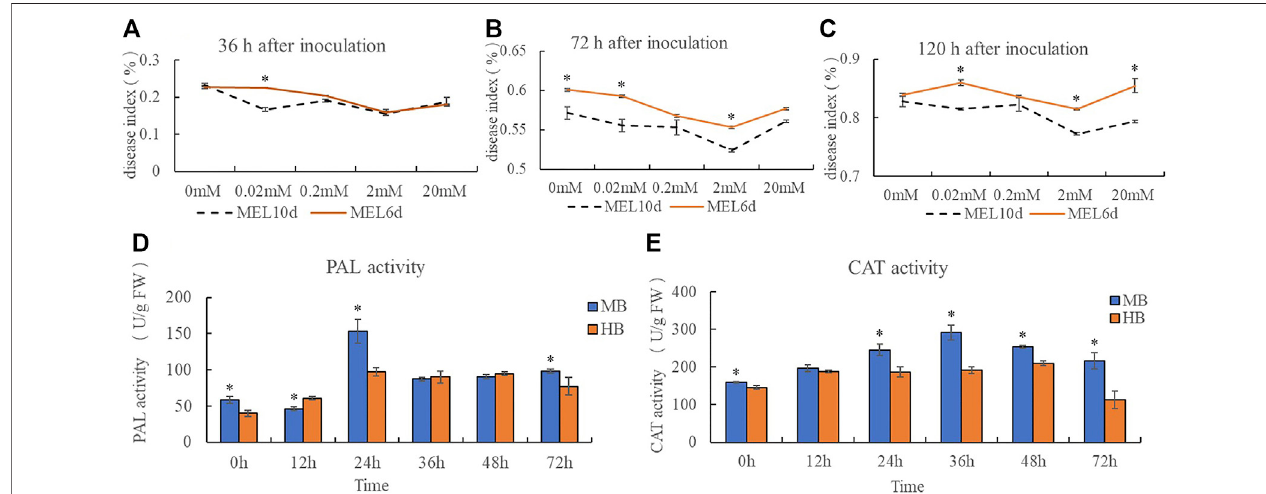
FIGURE1| Effectofexogenousmelatoninpre-treatmenton Lilium resistanceto B.elliptica . (A) Effectofmelatoninconcentrationondiseaseindexat36 hforplants pretreated with 0, 0.02, 0.2, 2 or 20 mM melatonin. MEL6d represents plants were pre-treatment with melatonin for 6 days (once every 2 days), MEL10d represents plants were pre-treatment with melatonin for 10 days (once every 2 days). (B) Effect of melatonin concentration on disease index at 72 h for plants pretreated with 0, 0.02,0.2,2or20 mMmelatonin.MEL6drepresentsplantswerepre-treatmentwithmelatoninfor6 days(onceevery2 days),MEL10drepresentsplantswerepre- treatment with melatonin for 10 days (once every 2 days). (C) Effect of melatonin concentration on disease index at 120 h for plants pretreated with 0, 0.02, 0.2, 2 or 20 mM melatonin. MEL6d represents plants were pre-treatment with melatonin for 6 days (once every 2 days), MEL10d represents plants were pre-treatment with melatoninfor10 days(onceevery2 days). (D) Effectofexogenousmelatoninpre-treatmentonPhenylalanineammonialyase(PAL)activityof Lilium afterinoculation.MB represents plants were pre-treatment with 2 mM melatonin and then inoculated with B. elliptica ; HB represents plants were pre-treatment with Milli-Q water [ethanol/ water (v/v) D 1/10,000], and then inoculated with B. elliptica . (E) Effect of exogenous melatonin pre-treatment on catalase (CAT) activity of Lilium after inoculation. MB represents plants were pre-treatment with 2 mM melatonin and then inoculated with B. elliptica ; HB represents plants were pre-treatment with Milli-Q water [ethanol/ water(v/v)D1/10,000],andtheninoculatedwith B.elliptica .Datarepresentmean±SEoftriplicateassays.ThelinechartsweregeneratedbasedonIBMSPSSStatistics 20. The “ * ” represents the signi fi cant